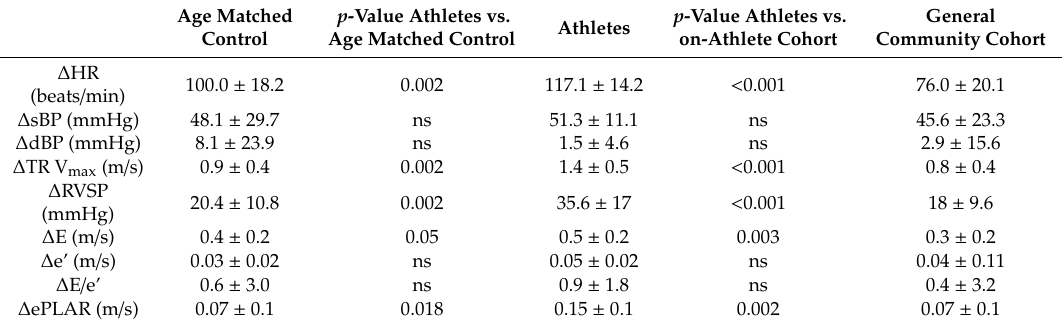
Table 2. The mean change and corresponding p -values in age matched controls vs. athlete population vs. general community cohort from pre- to post-exercise. p -Value Athletes vs. p -Value Athletes vs. General Age Matched Athletes on-Athlete Cohort Community Control Age Matched Control